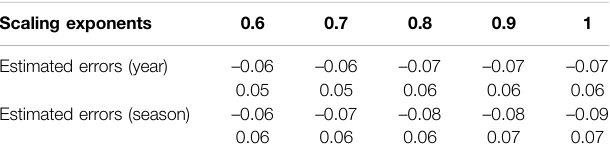
TABLE 3 | The values in the 2.5th and 97.5th percentiles for DFA2 ’ s estimated